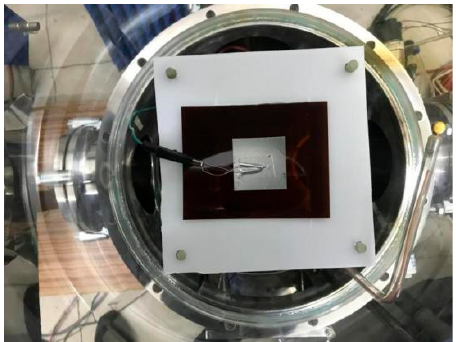
Figure 3. ESD test of dielectric materials induced by ESD field pulse.